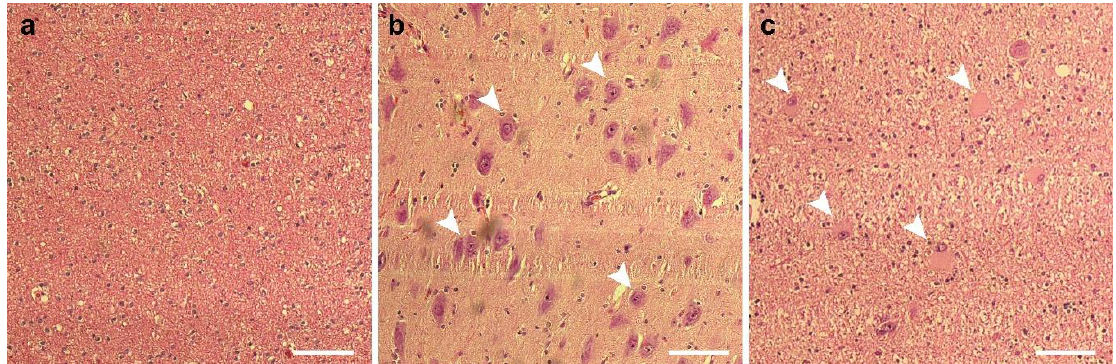
Figure 3. Hematoxylin–eosin staining of the surgically resected brain tissue from case 4. Adjacent healthy control tissue ( a ) from the same brain. Dysmorphic neurons ( b ) and balloon cells ( c ) from the lesion. Scale bars ( a – c ) 100 µm. Abnormal cells are semiquantitatively estimated to compose approximately 50% of the cell population in the collected lesion tissue (not shown).